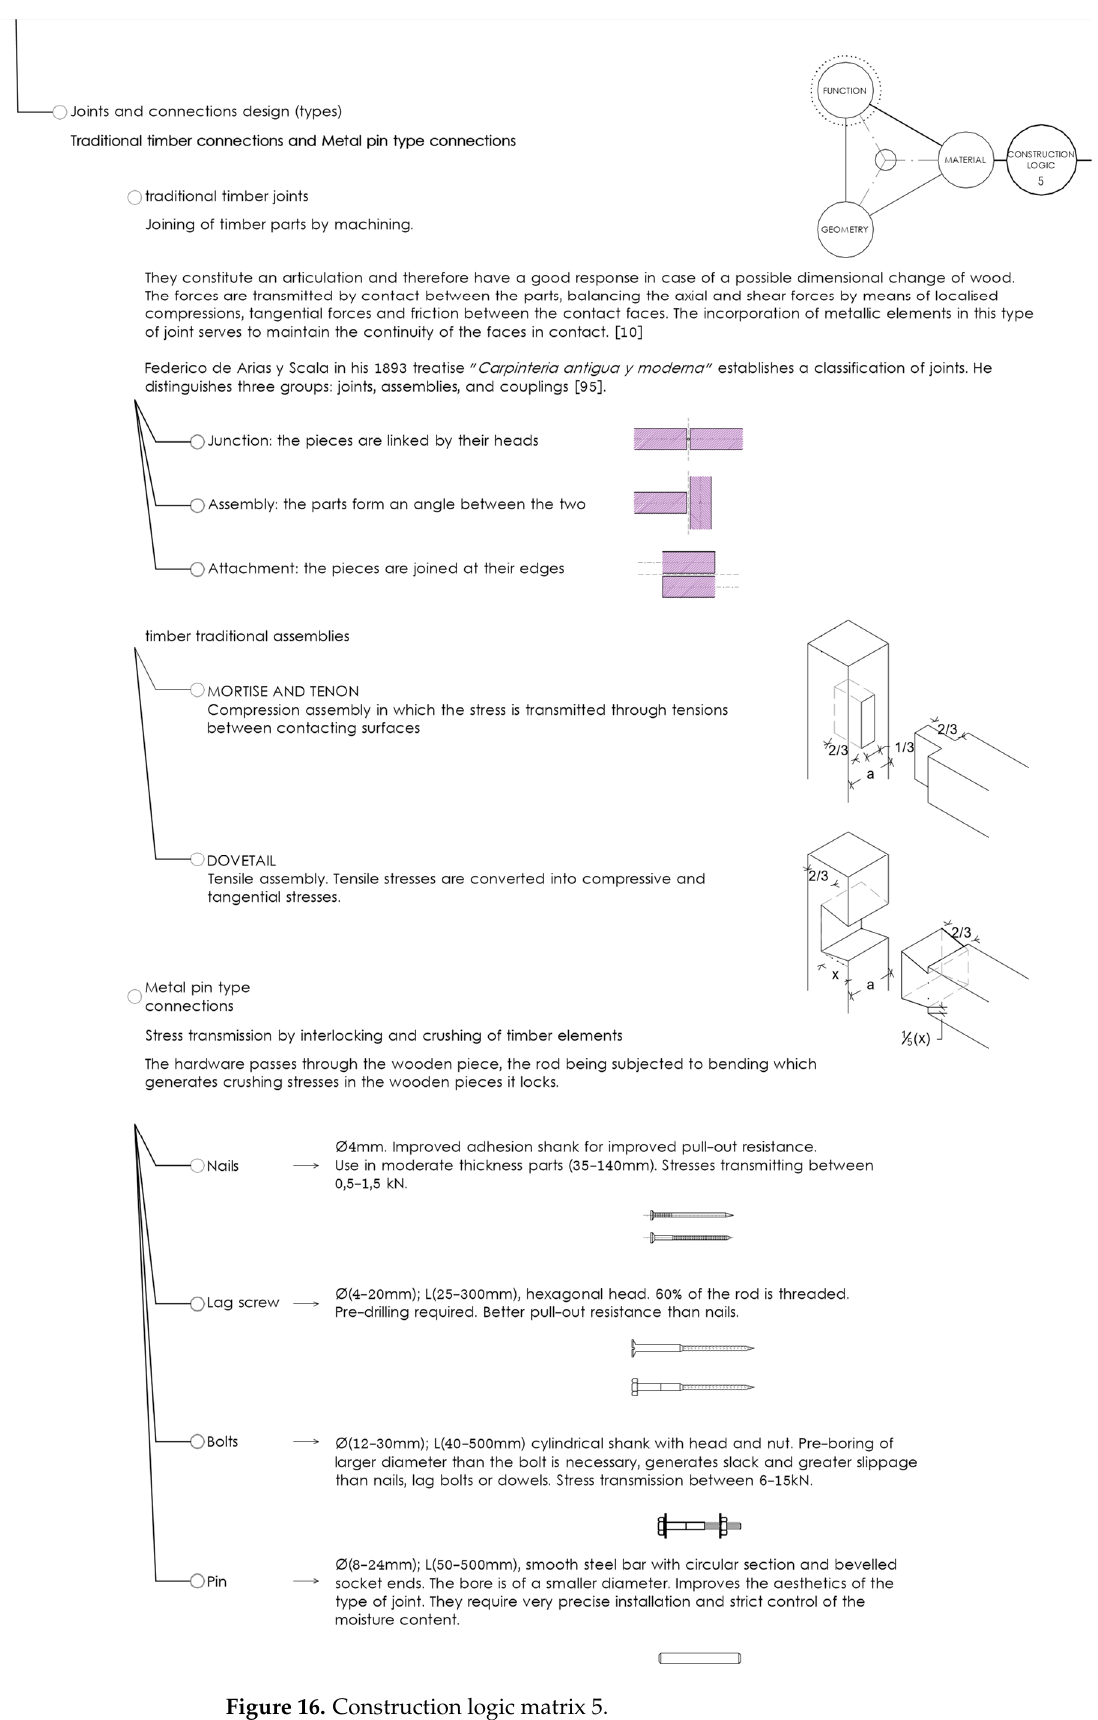
Figure 16. Construction logic matrix 5.